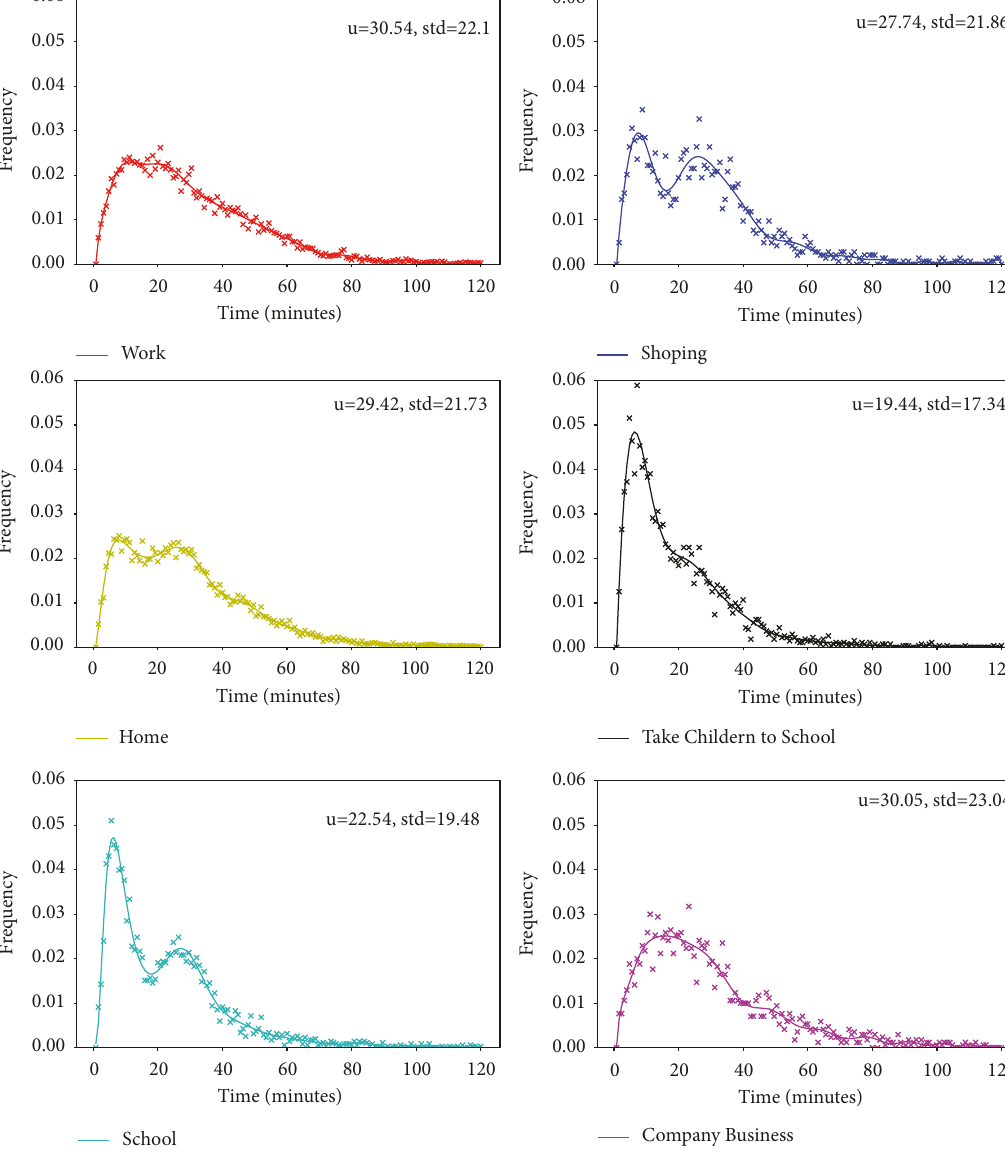
Figure 8: Trip time distribution with 6 travel